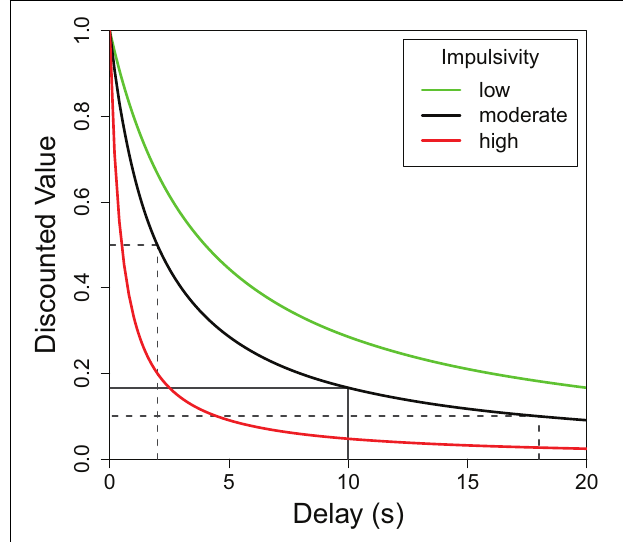
FIGURE 1 | The subjective value of a delayed reward. The discounted value of a delayed reinforcer is modeled by a hyperbolic function. Here f ( delay ) = ( 1 + K × delay ) − 1 where “ K ” defines the shape of the discounting curve (green: K = 0 . 25, black: K = 0 . 5, red: K = 2 . 0). Higher K -values (red) are characteristic of greater impulsive choice. In each case, the average of the values of the variable options—shown, for the black function, in dotted lines—is greater than the value of their average which is shown as a solid line. This difference (Jensen’s inequality) holds for any concave up function, but the difference is greater for functions with higher K -values. In other words, the difference between the variable and fixed delay options is greatest for the red line, moderate for the black line, and least for the green